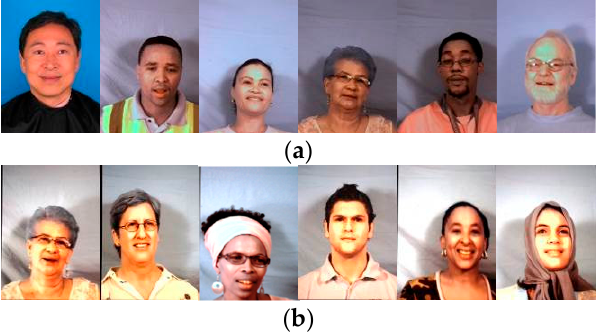
Figure 14. Samples of test face images (in 4557 images). ( a ) Samples of authentic images; ( b ) Samples of spoofed images (displayed by iPad).